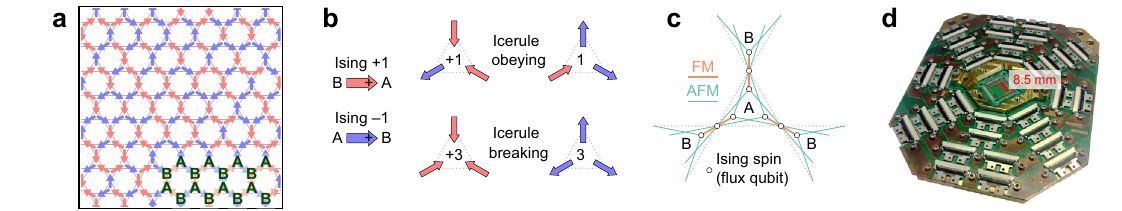
Fig. 1 | Kagome qubit ice. a Kagome spin ice consists of magnetic dipoles on the edgesofahexagonallattice,whichpointinoroutoftriangularplaquettes(vertices) of the dual kagome lattice (gray lines). b Each vertex in a given con fi guration hasa nonzero charge:±1-charged vertices satisfy the kagome ice rule;±3-charged ver- ticesdonot.DenotingtrianglespointingupanddownbyAandB,respectively,one canmapdipolestoIsingspinsaccordingtowhetherornotthedipolepointsintoan